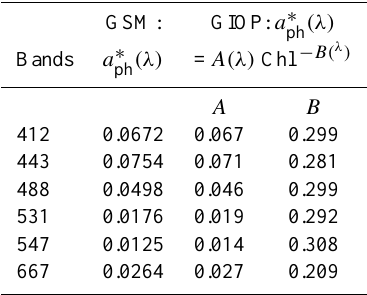
(λ) for tuned GSM and ph